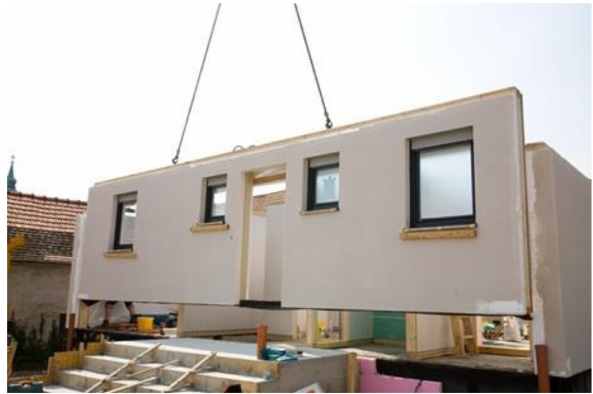
Figure 1. Prefabricated sandwich construction system